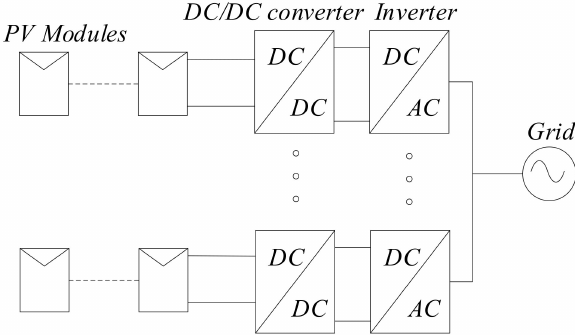
Figure 2. Parallel structure of the grid-connected photovoltaic